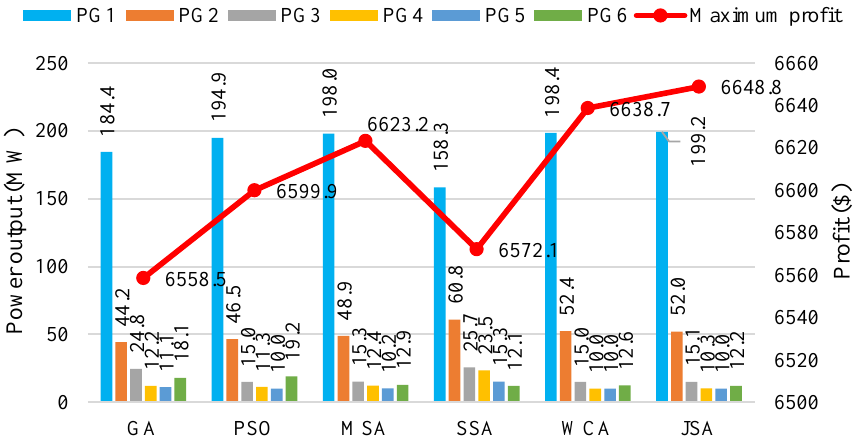
Figure 6. Chart of power output obtain by different methods case 1.